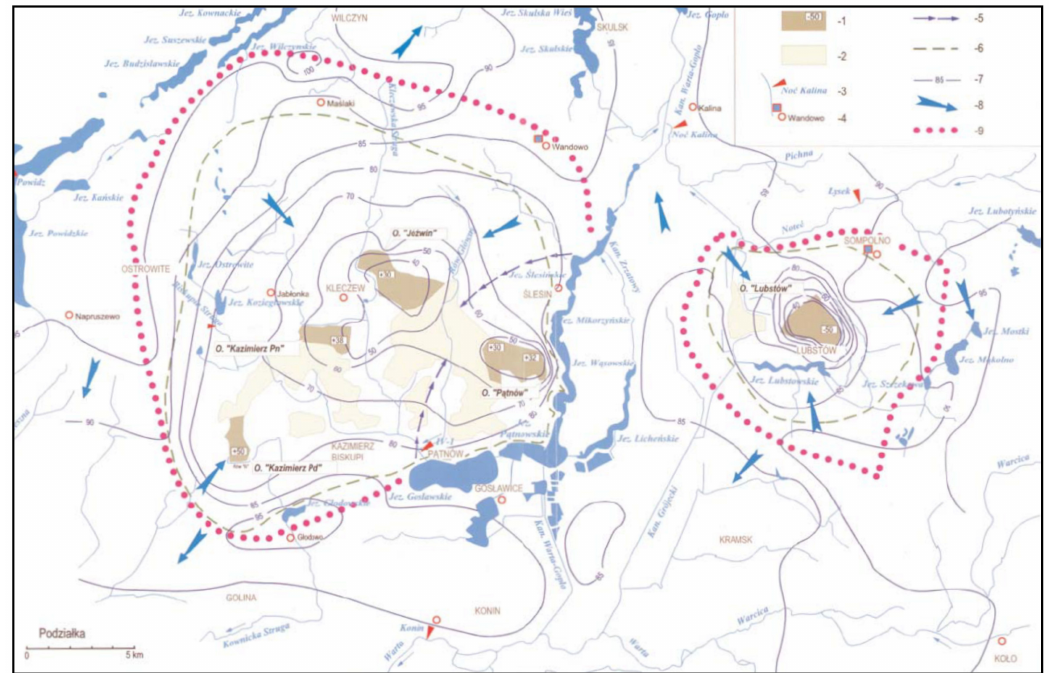
Figure 1. Location of coal deposits and cones of depression in the district of Konin as of 1996. Source: Map from [113]. Map legend: 1-lignite open-cast mines and a level of the drainage of coal bed; 2-external waste banks; 3-rivers and water level gauges of the Institute of Meteorology and Water Management; 4-rainfall and groundwater measuring stations of IMGW; 5-boundaries of the inflow zone of filtered water from lakes; 6-the range of the cone of depression in the Cretaceous-Neogene aquifer; 7-hydroisohipsa curves (meters above sea level) of the water table of the Cretaceous-Neogene aquifer as of 1996; 8-directions of groundwater runoff; 9-hydrogeological water parting of the catchment